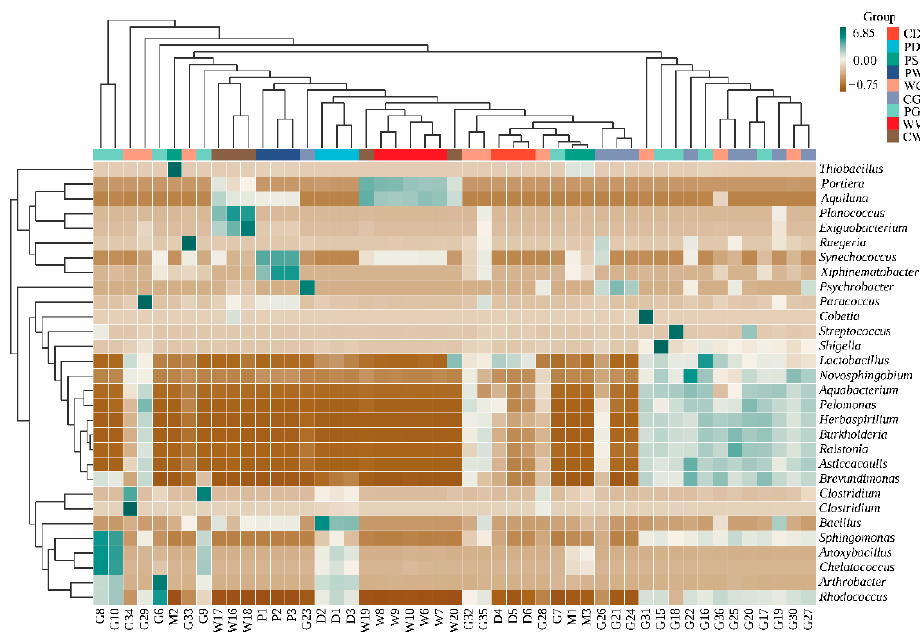
Figure 2. Heatmap showing genus-level microbial composition. The relative abundance shown represents the mean relative abundance for the corresponding